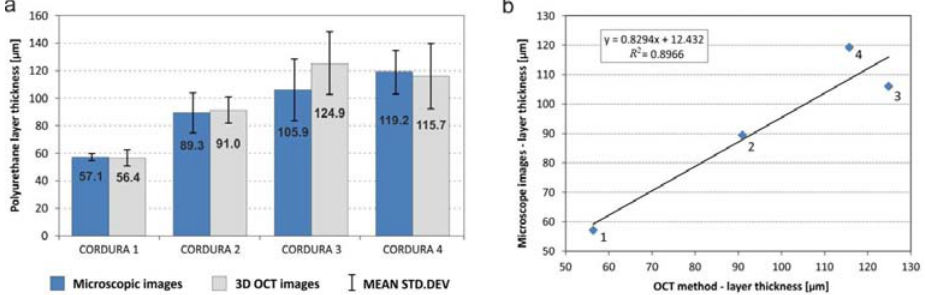
Figure 14. ( a ) Mean values of polyurethane lamina thickness for four types of Cordura obtained using a manual method from microscope images and automated measurements of OCT images; ( b ) The results had a strong relationship, with a coefficient of determination of R 2 = 0.8966, b and a Pearson correlation coefficient of r = 0.9844. Polymers 2018 , 10 , x FOR PEER REVIEW 14 of 17